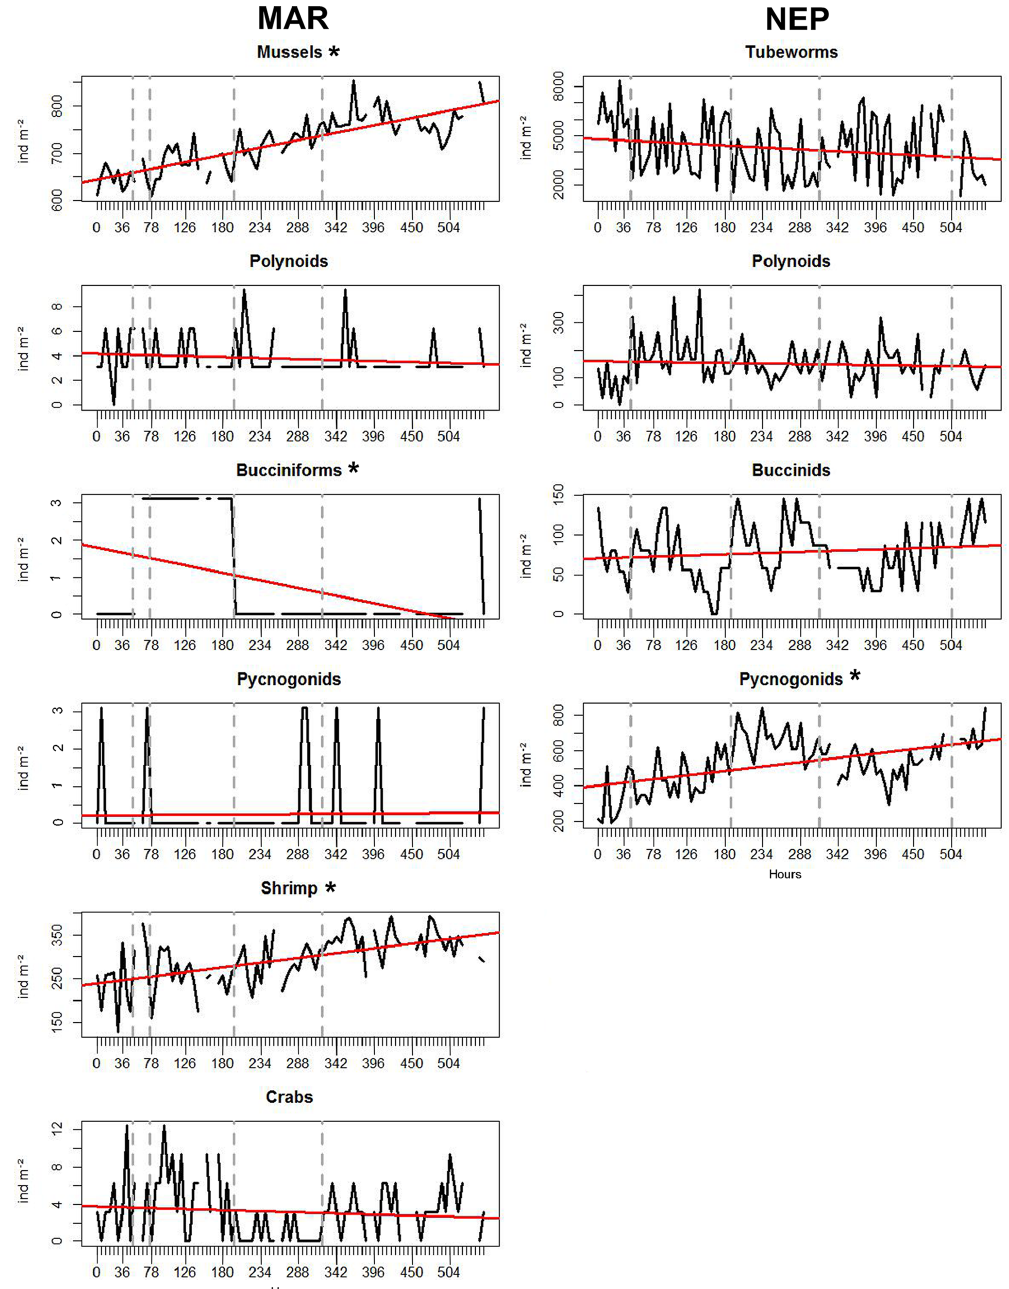
Figure 3. Temporal variations in faunal densities for MAR and NEP along with trend lines (in red) and MRT temporal groups (grey vertical dotted lines); x axis shows the sampling frequency every 6h. Taxa with significant trends ( p <0.05) are marked with an